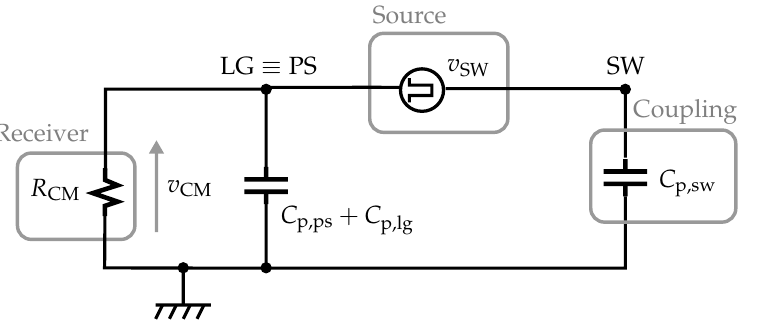
Figure 3. Equivalent circuit for the analysis of the CM electro-magnetic interference (EMI) in a half-bridge. The source voltage corresponds to the switching voltage v sw , the coupling is due to the parasitic capacitance C p,sw and the receiver is modeled by the LISNs equivalent impedance.